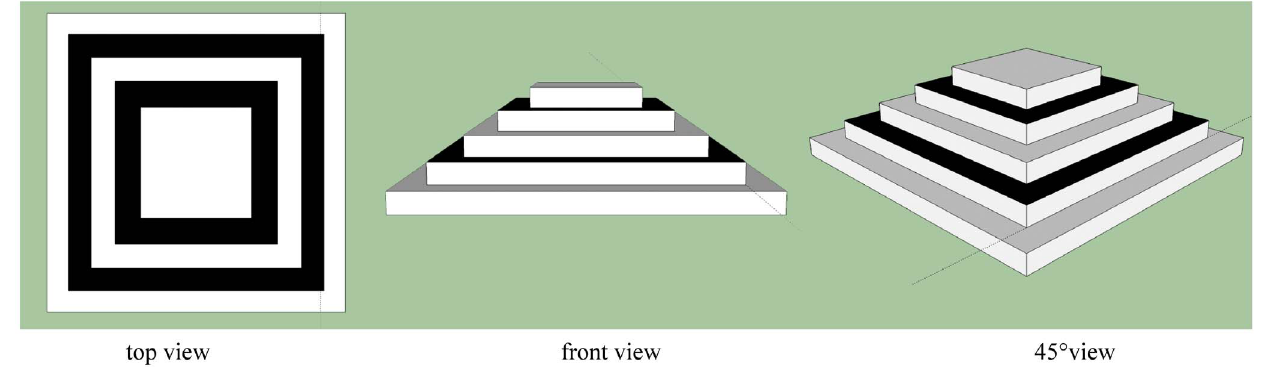
Figure 4. Perspectives on the wooden pyramid. Pictures of the wooden pyramid were taken from three different perspectives: from above, in front and from 45